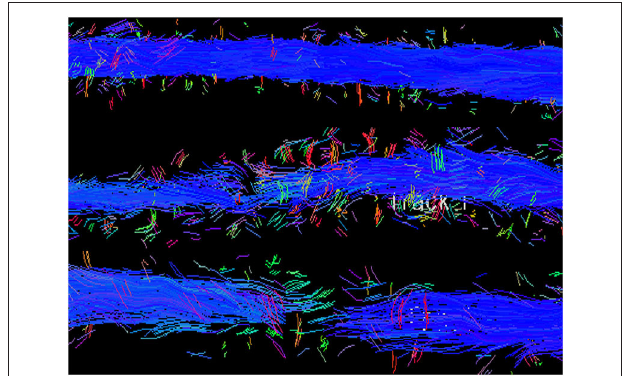
FIGURE 15 | Tractography of the spinal cord from a normal dog (top) compared to dogs with SCI showing moderate fiber disruption (middle) and complete trans-lesional discontinuity (bottom). Blue depicts cranial to caudal oriented fibers.